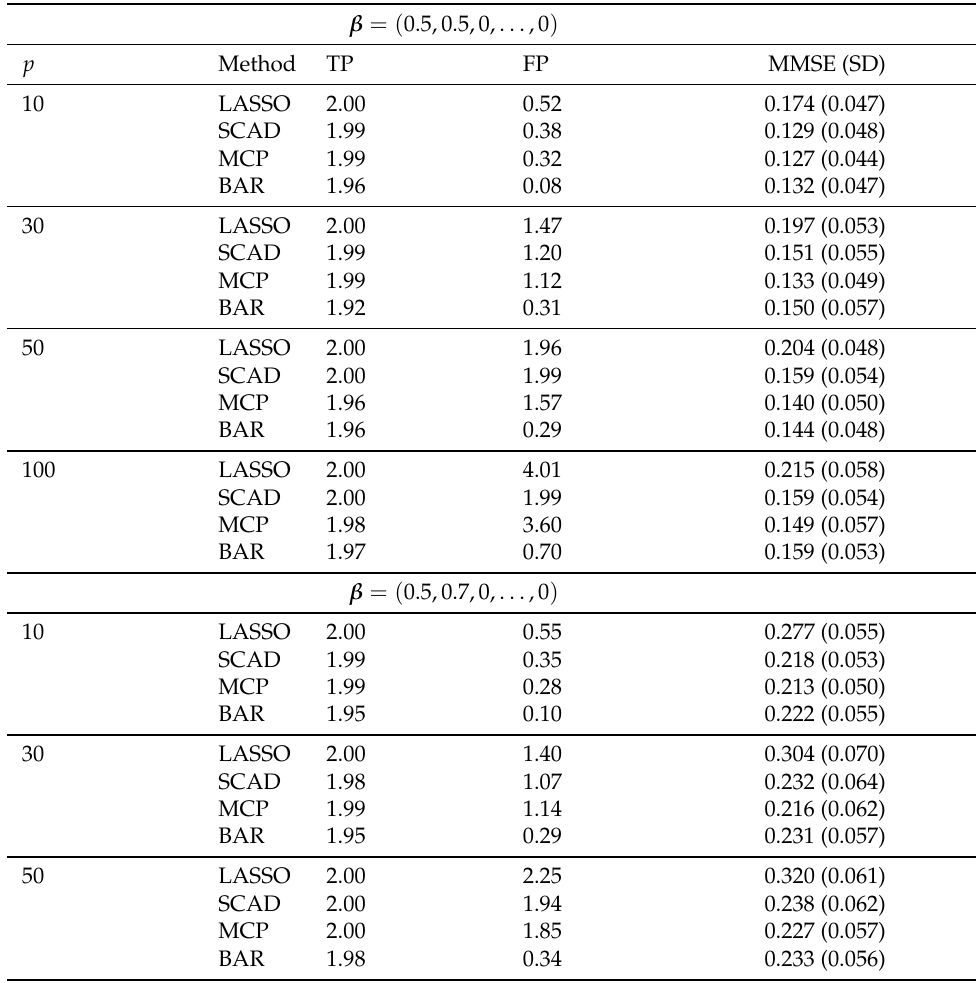
Table 2. Simulation results based on the joint selection of the tuning parameter and bandwidth n = 300 for